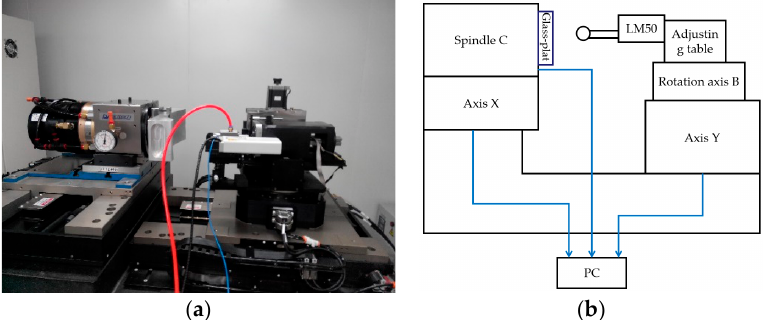
Figure 8. Precision measurement platform. ( a ) Measurement platform; ( b ) Schematic diagram.